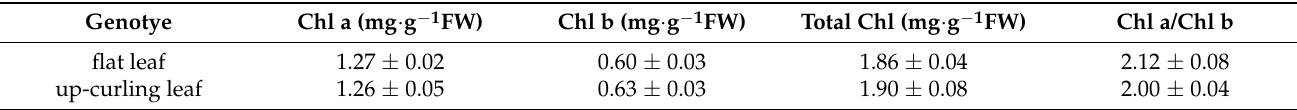
Figure 1. ( a , b ) Leaf phenotype at the seedling stage of ZS11, NJAU-M1295, and their F 1 hybrid (Bar = 5 cm). The leaf chlorophyll (Chl) content and photosynthetic indicators of the F 2 population were determined to evaluate the effect of the up-curling of leaves. The leaf chlorophyll a (Chl a), chlorophyll b (Chl b), and total Chl levels (Table 1) were not different between the plants with up-curling leaves and those with normal, flat leaves. Measurement of the gas-exchange parameters leaves. Meanwhile, the stomatal conductance, intercellular CO 2 concentration, and leaf transpiration rate of up-curling leaves were significantly higher than those of flat leaves (Table 2). These observations indicate the negative effect of leaf up-curling on photosynthetic efficiency to a certain extent. Table 1. Leaf chlorophyll contents of homozygous up-curling leaf and flat leaf in F 2 population derived from NJAU-M1295 and ZS11 (mean ± SD, n = 5 for each sample).